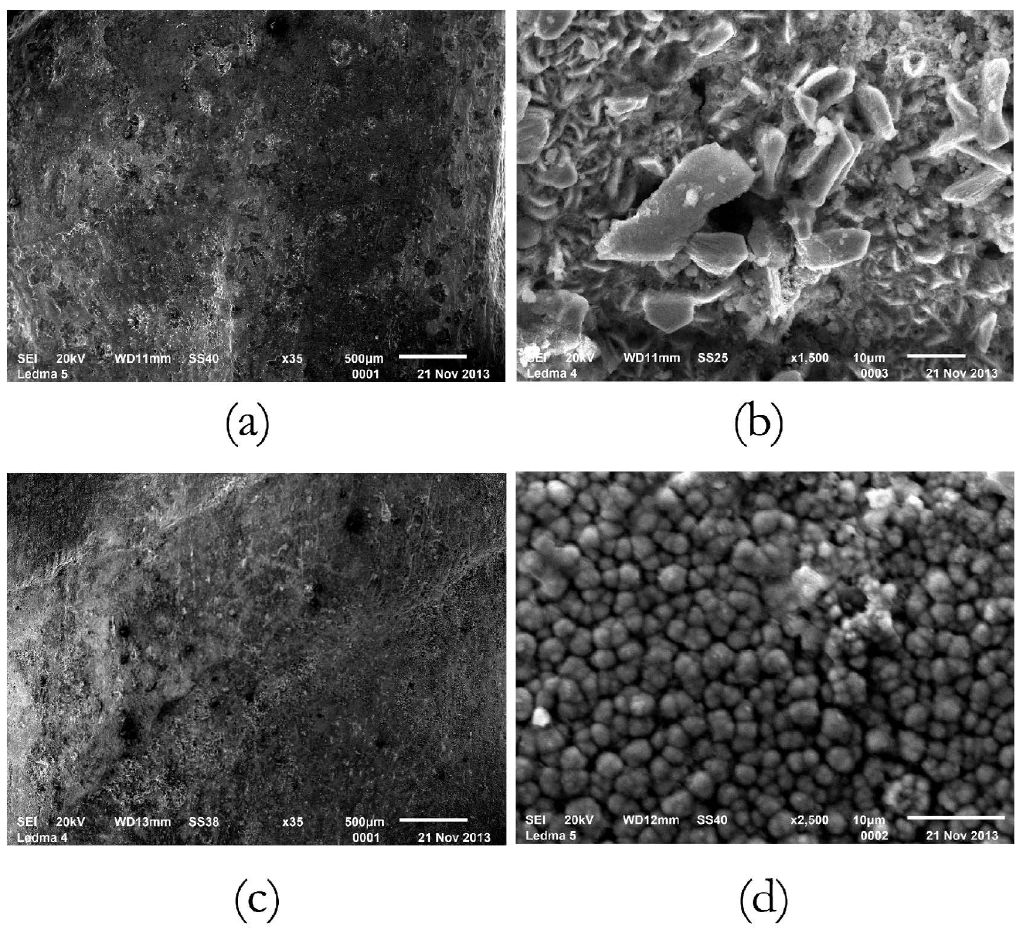
Figure 2. Morphology of film formed on rebar surface after the Zinc (A and B) and Zinc-Nickel (C and D) electroplating process.